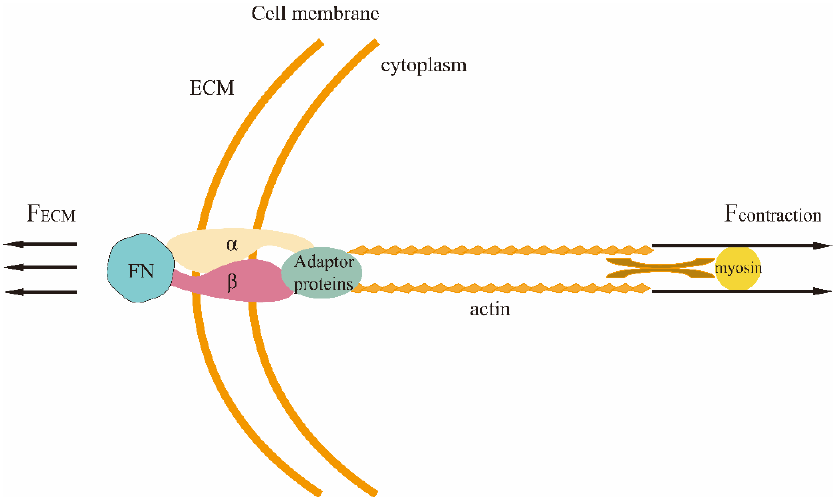
Figure 4. Tension homeostasis between cells and the ECM.